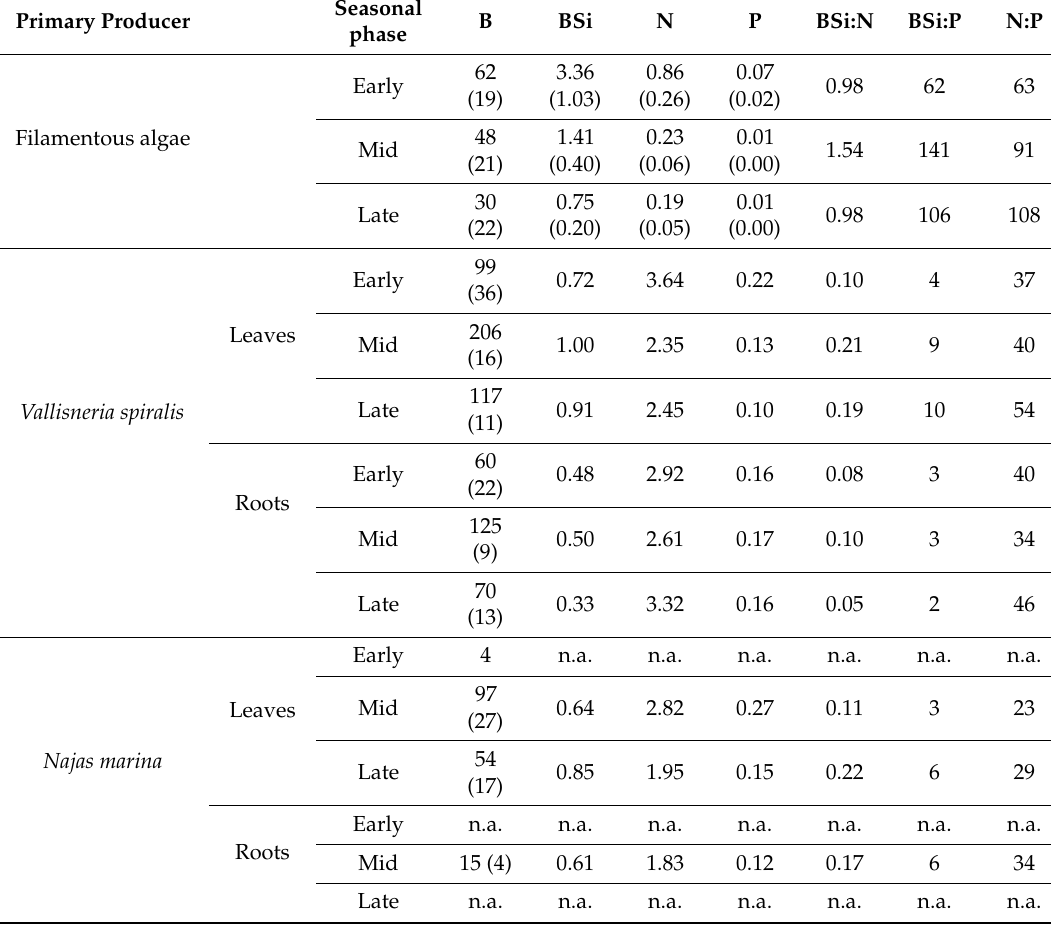
Table 4. Biomass (B, g DW m − 2 ), biogenic silica (BSi, %), nitrogen (N, %) and phosphorus (P, %) content and BSi:N, BSi:P and N:P molar ratios in filamentous algae and macrophytes (leaves and roots). All data represents mean ± standard error (standard error in parenthesis), n.a. = not available. Primary